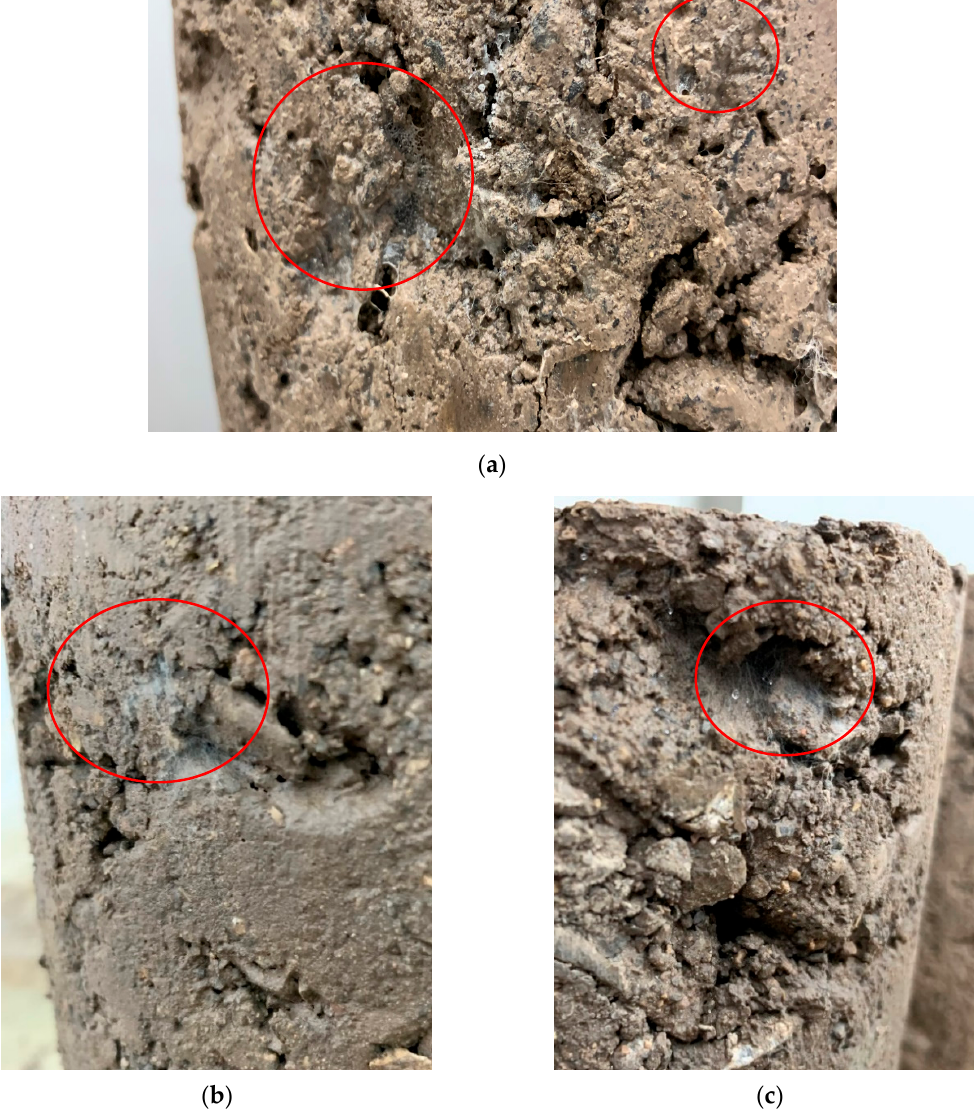
Figure 6. Visible polymer film on the surface of CBM grains. ( a ) CBM_C2P4; ( b ) CBM_C0P2; ( c ) CBM_C2P2, (source: M. Krasowski).